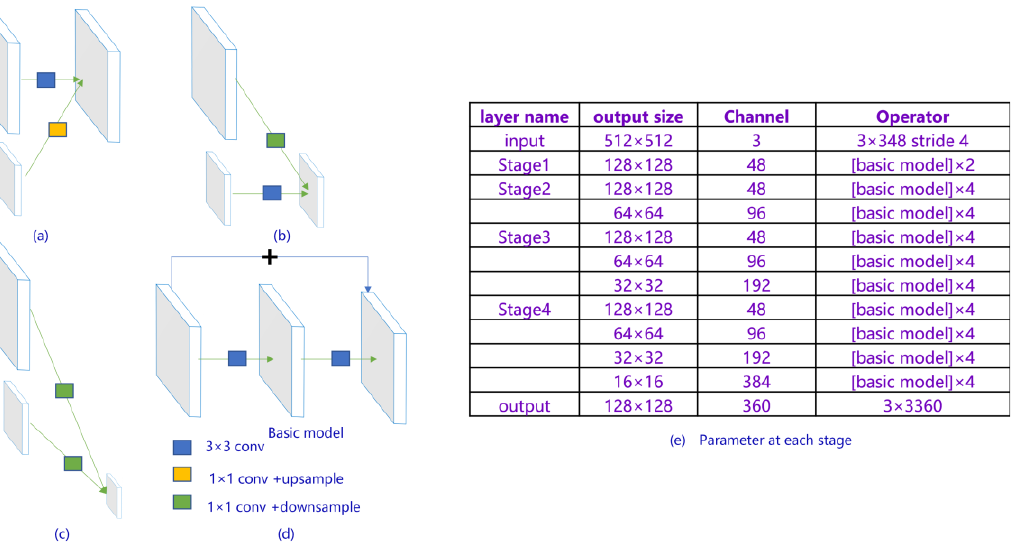
Figure 5. ( a – c ) Feature forward from stage 2 to stage 3. ( d ) The basic model of stages 1 – 4. ( e ) Param- eter at each